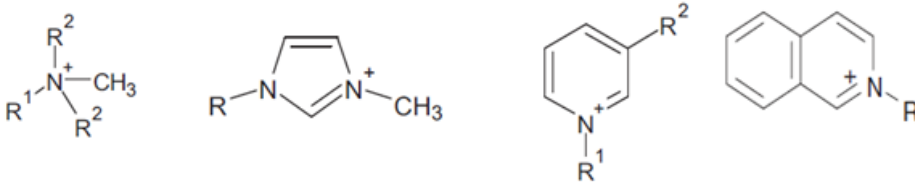
Figure 2. Examples of cations most often included in the structure of ILs.